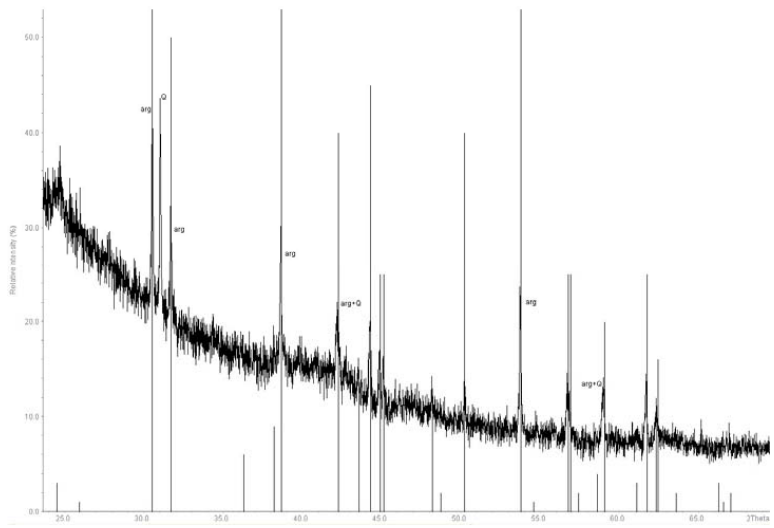
Fig. 9 X-ray pattern of the suspended fraction. Peaks of aragonite are clearly